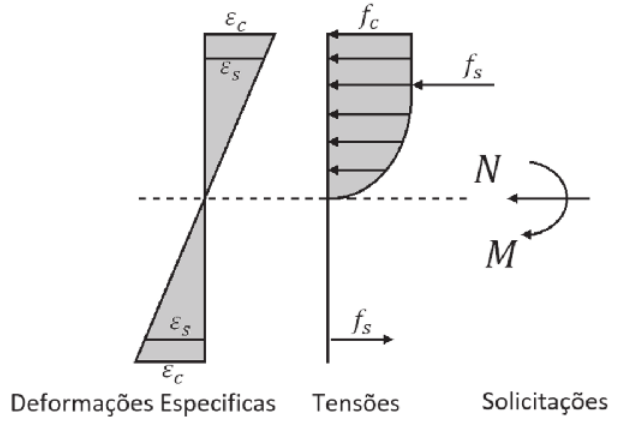
Figura 5 Equilíbrio na seção transversal para flexão composta reta, à temperatura